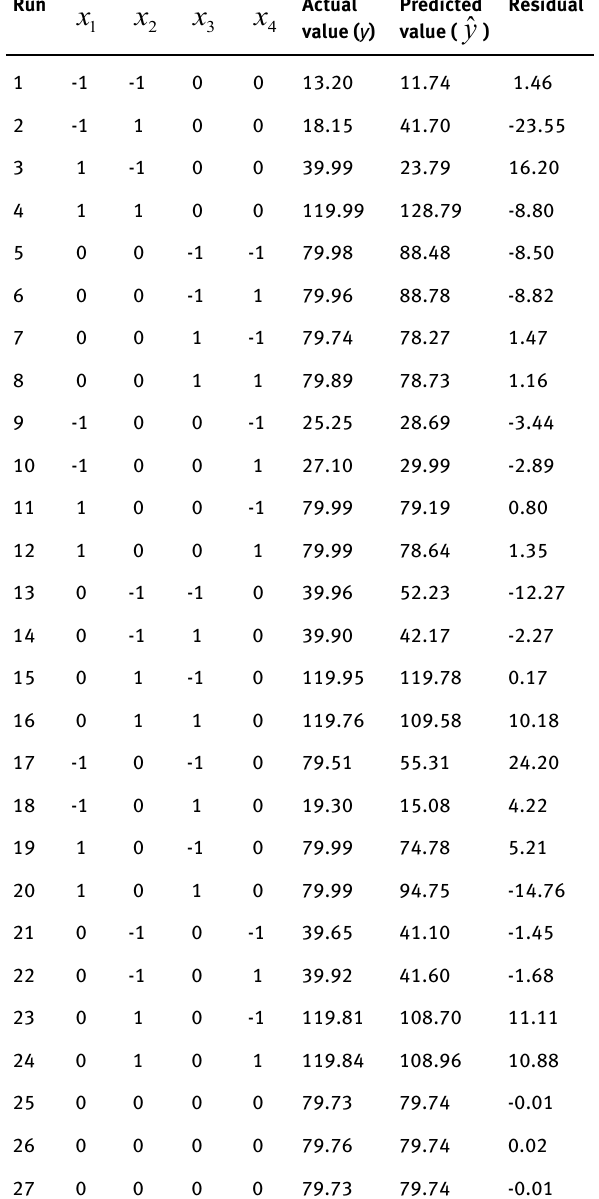
Table 2: Box-Behnken design and values of micronized calcite heavy metal capacity.